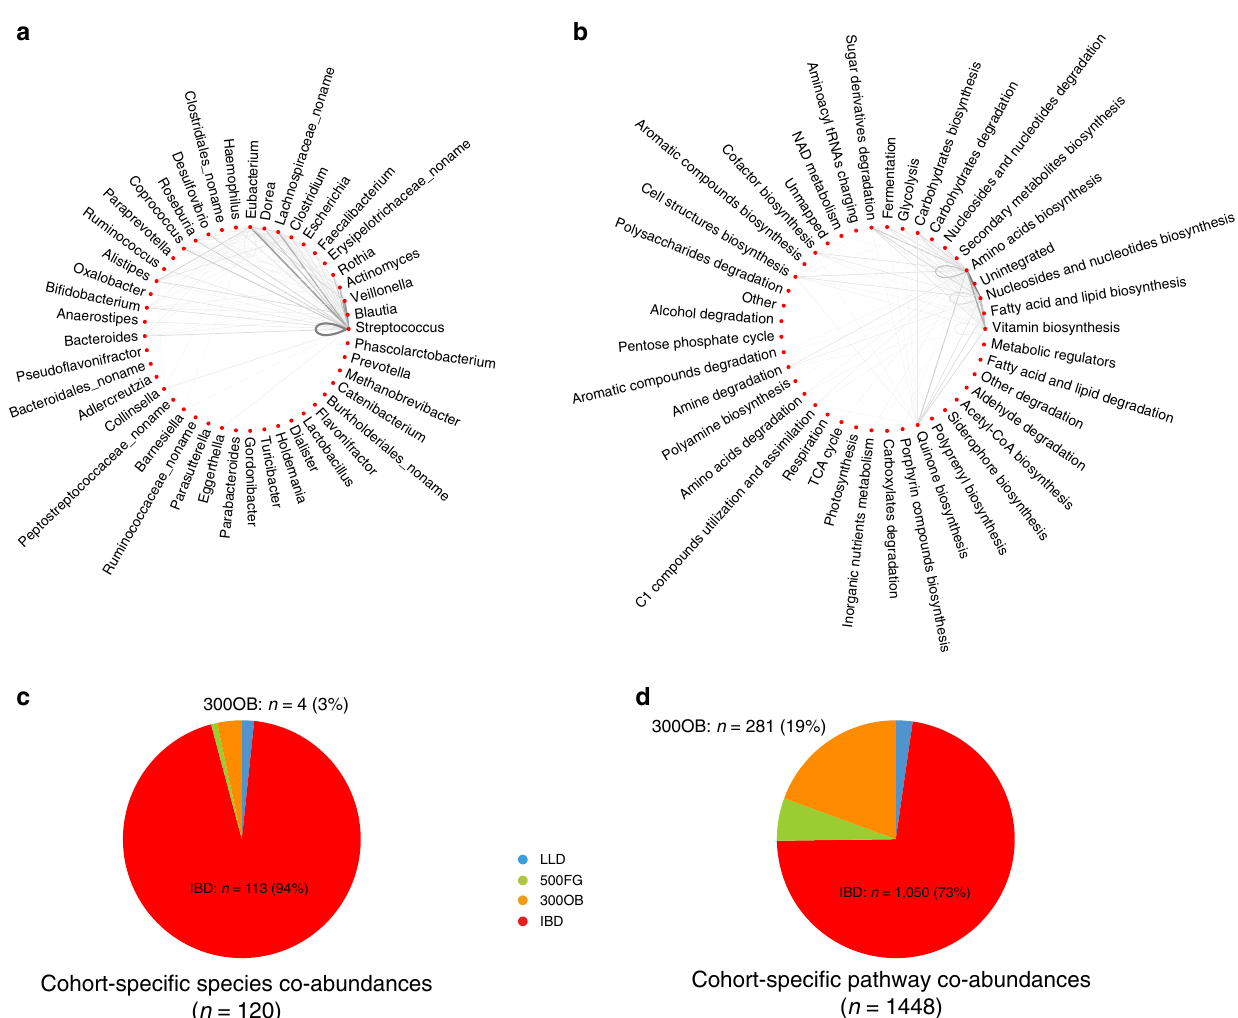
Fig. 3 Differential and cohort-speci fi c microbial co-abundances. a Differential species co-abundances involved in 45 microbial genera. b Differential pathway co-abundances involved in 41 microbial metabolic categories. Each dot indicates one microbial genus or metabolic category. Each line represents differential species or pathway co-abundances between species or pathways from either the same or different genera or metabolic categories. The width and darkness of the lines represent the relative number of differential co-abundances. c Pie chart of 120 cohort-speci fi c species co-abundances showing the proportion of speci fi c co-abundances detected in each cohort. d Pie chart of 1448 cohort-speci fi c pathway co-abundances showing the proportion of speci fi c co-abundances detected in each